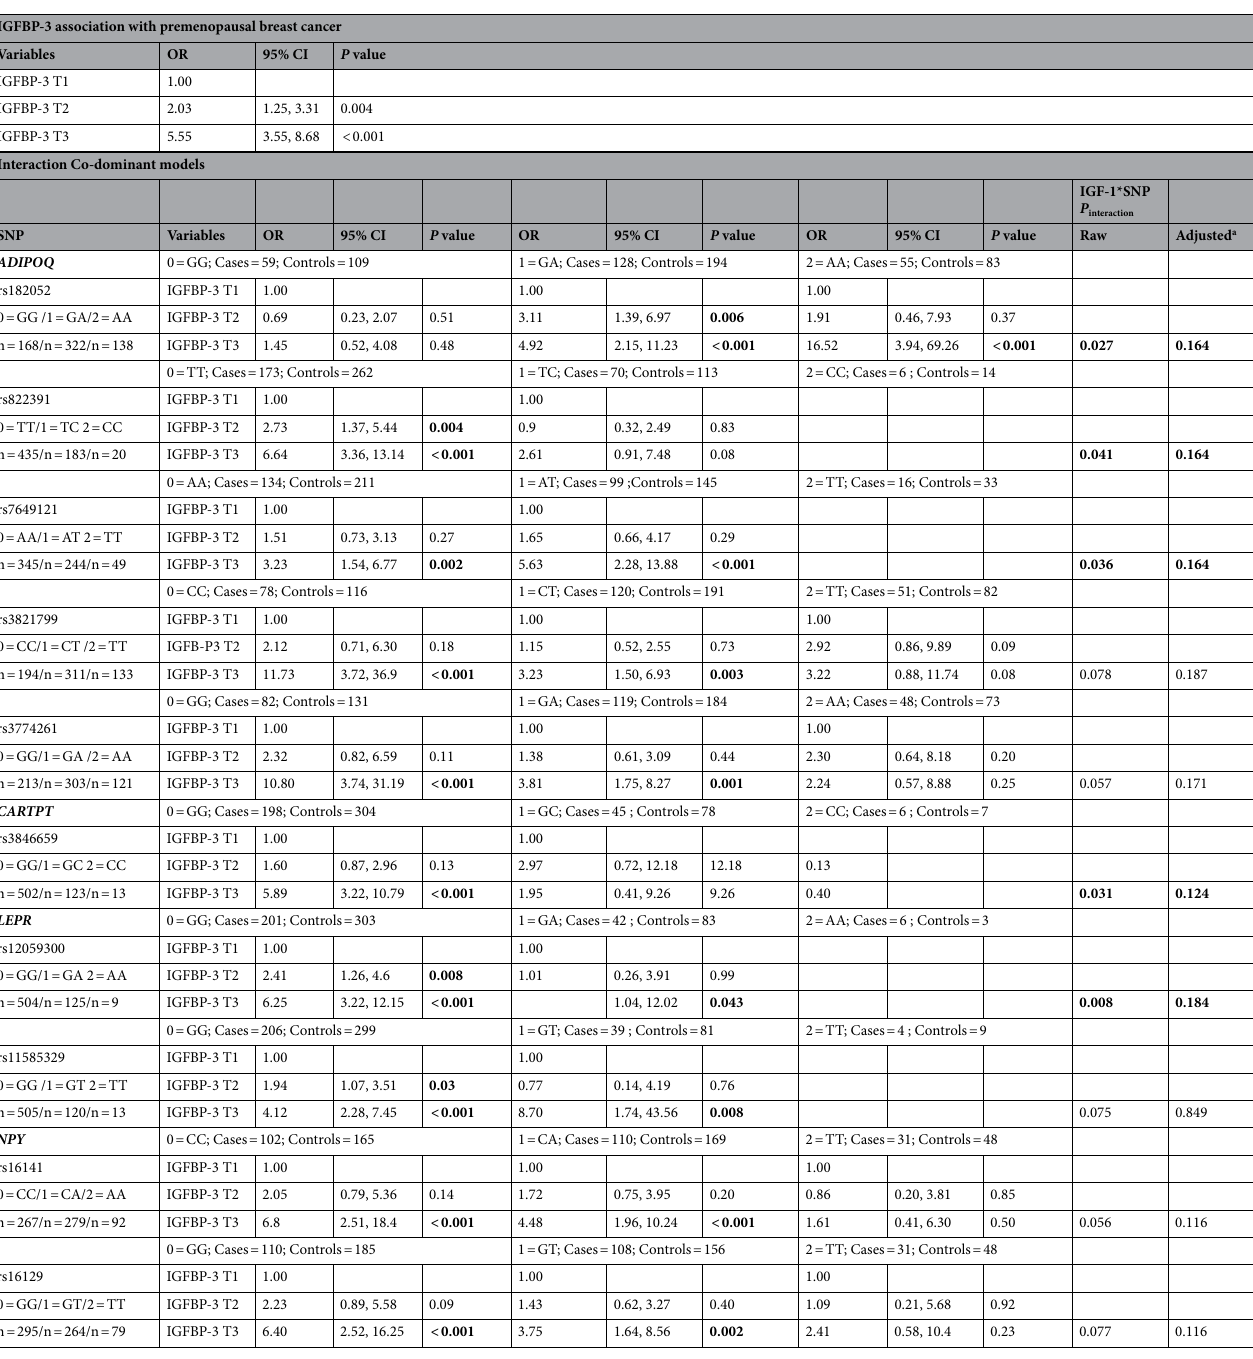
Table 3. Association between serum concentration of IGFBP-3 and breast cancer by SNPs of genes regulating energy homeostasis, the Breast Cancer Health Disparities Study. The model at the top of the table was not adjusted for potential confounders. The rest of the models were adjusted for IGF-1 serum concentration (ng/ mL), age (years), genetic ancestry (% Indigenous), BMI (Kg/m2), energy intake (Kcal/day), height (cm), age at menarche (years), ever use oral contraceptives (no,yes), parity (nulliparous, 1 or 2, 3 or more), study (4-CBCS, MBCS), first-degree family history of breast cancer (no, yes), ever alcohol consumption (no, yes) and ever cigarette smoking (no, yes). a Benjamini-Hochberg adjusted P value (correction for the number of SNPs tested per gene); a threshold of 0.2 was considered